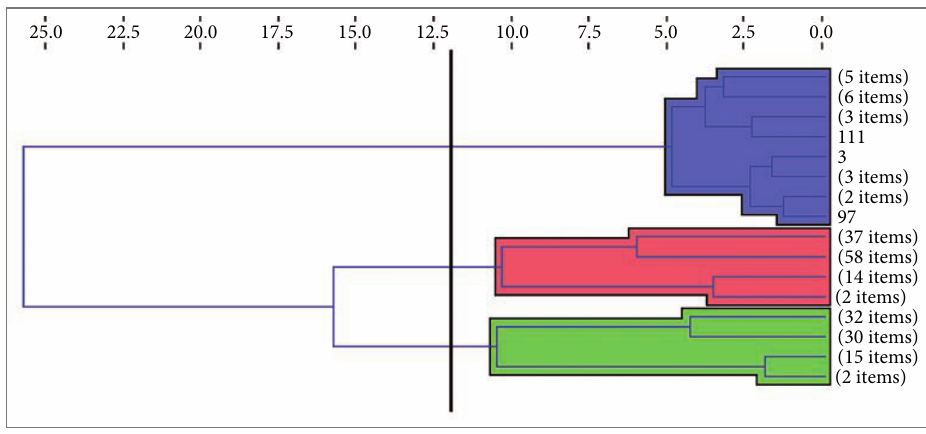
Fig. 5. Examples of class M are grouped into clusters. Optimal number of clusters – 3 (cut-off line at height 12)